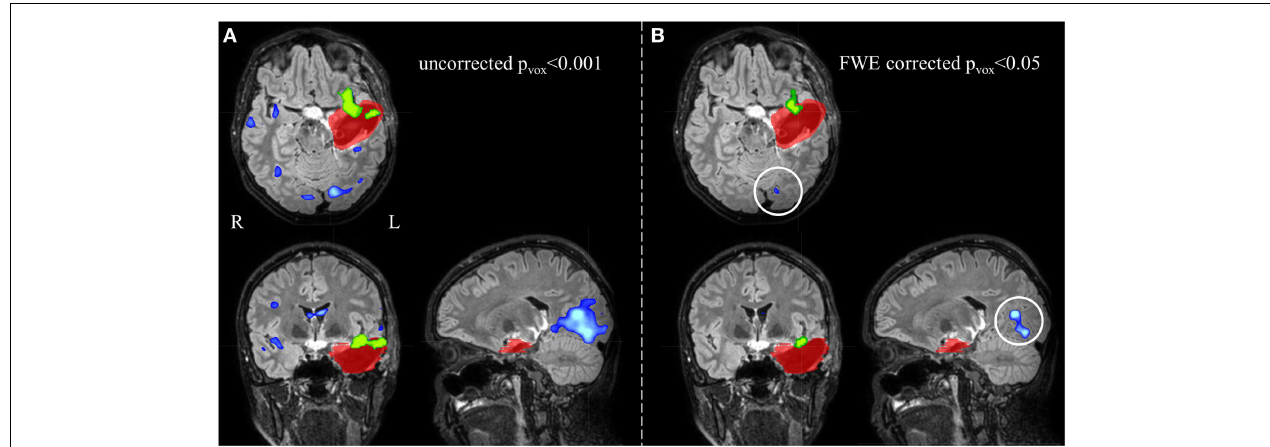
suprathreshold activation clusters (blue colored) are present. At these settings, it is unclear whether these activations outside the IOZ represent false- or true-positive activations. (B) Using a more stringent statistical threshold (corresponding to 100% specificity), fewer activation clusters survive.The left occipital activation (white circle) is not a false-positive but a true-positive detection and is considered part of a spike-related network; R, right; L, left.